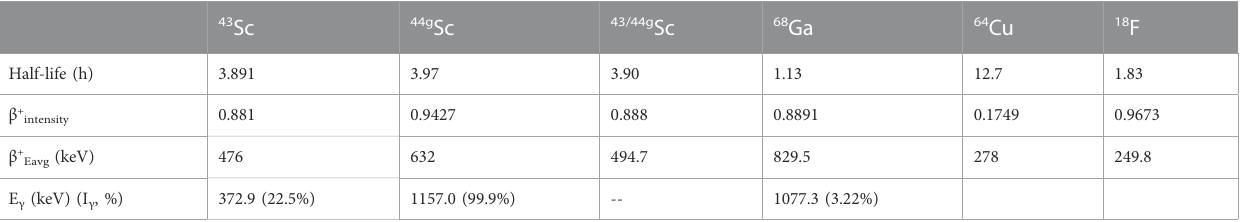
TABLE 2 Physical decay characteristics and effective half-life and positron intensity of the radionuclides used in this study (National Nuclear Data Center, Brookhaven National, 2022).